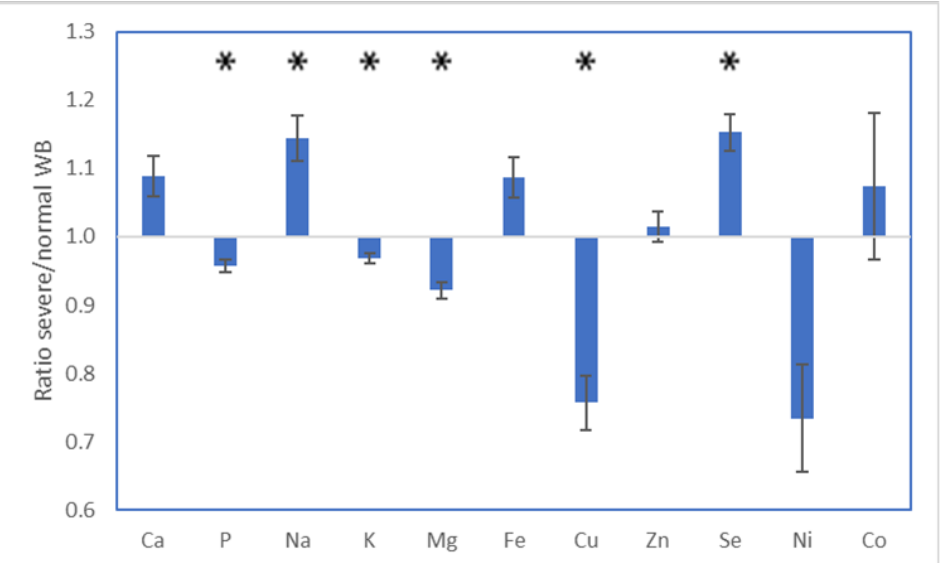
Figure 2. Effect of WB on tissue mineral level. Ratios are in relation to the normal WB group (* p < 0.05).